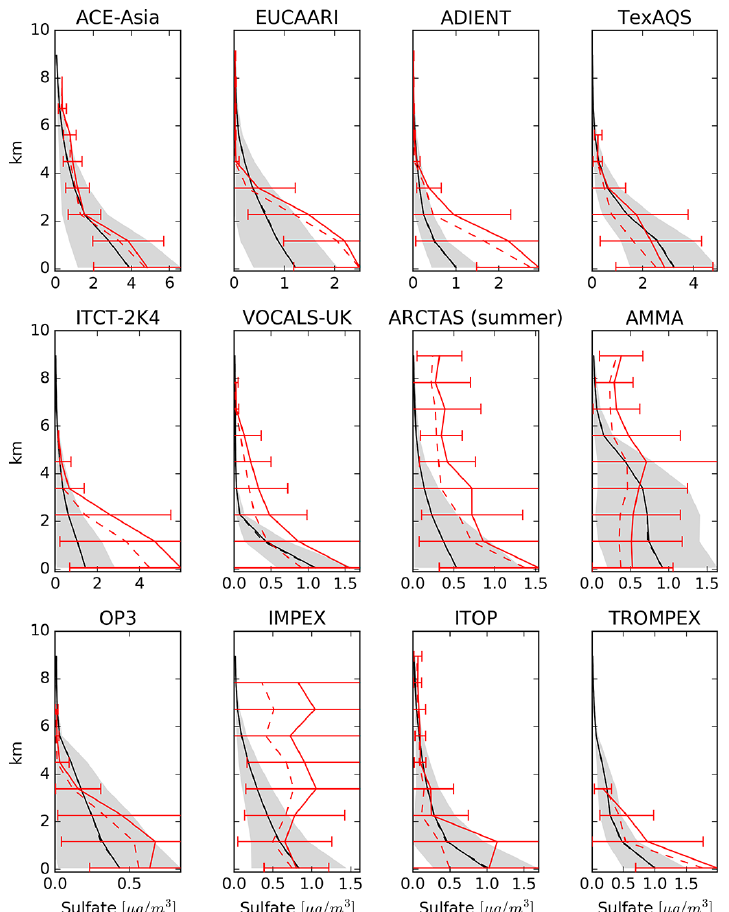
Figure 22. Model results of mean vertical profile of sulfate aerosol for selected field campaigns in black, and the spatiotemporal standard deviation is shown as a grey area. The observed mean values are depicted in solid red, with the bars representing the standard deviation of the observations. The observed median is presented as dashed red line.